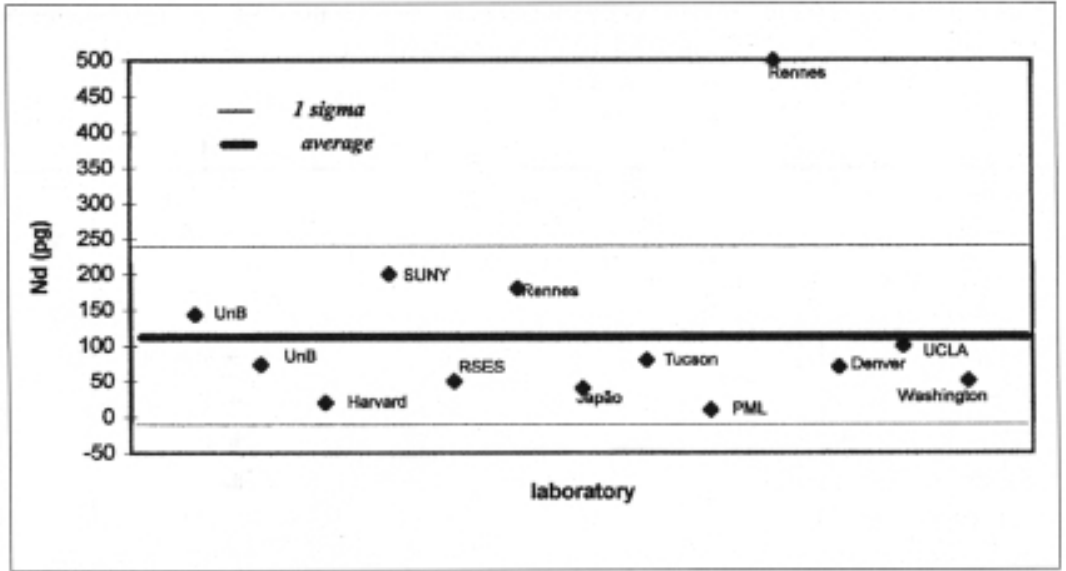
Fig. 5 – Interlaboratorial comparison of the experimental